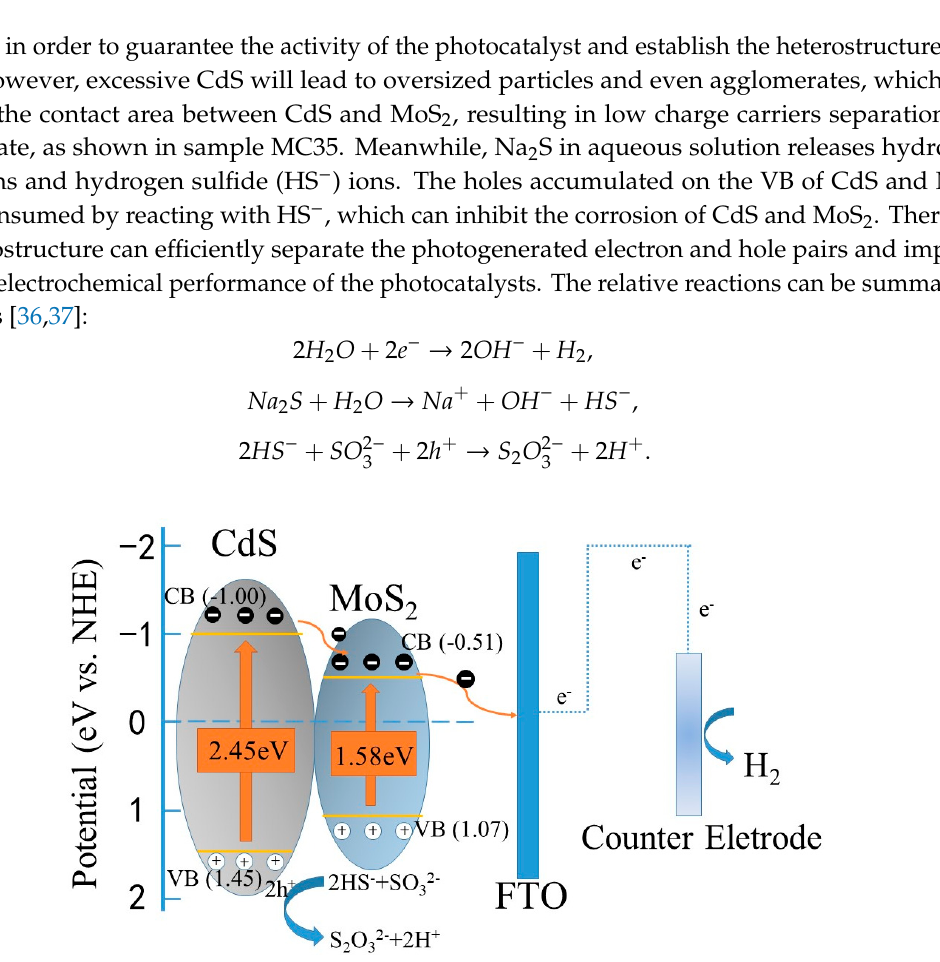
Figure 9. Schematic of the MoS 2 sheets / CdS nanoparticles heterojunction photocatalytic system. FTO—fluorine-doped tin oxide; NHE—normal hydrogen electrode; CB—conduction band; VB—valence band.